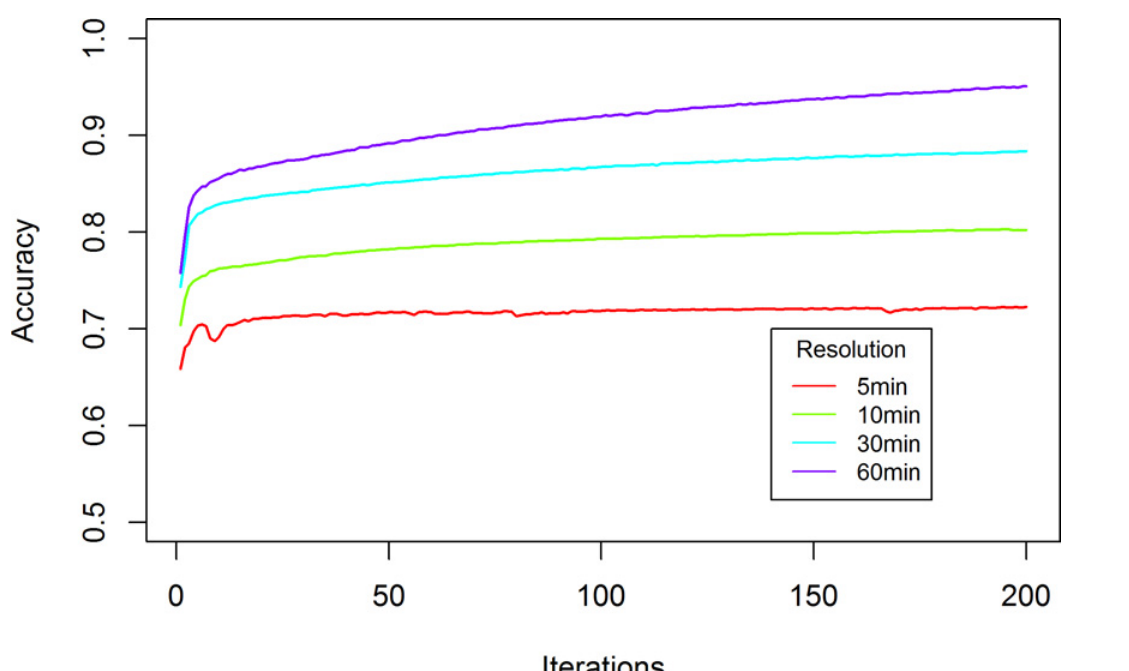
Fig 5. Training Accuracy Changing Curves with Different Data Aggregation